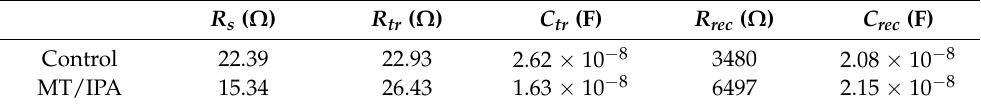
Table 2. EIS corresponding parameters fitted according to Nyquist equivalent